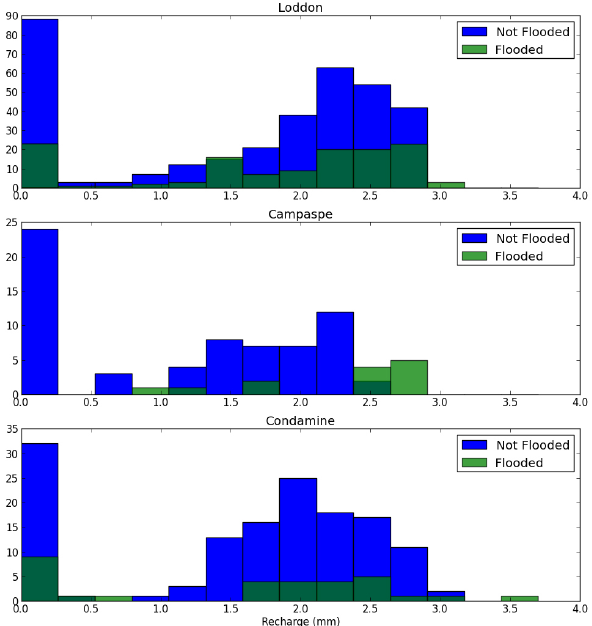
Fig. 7. Comparison of histograms for recharge calculated using the WTF method in flooded and not flooded areas of the Loddon, Cam- paspe and Condamine catchments.